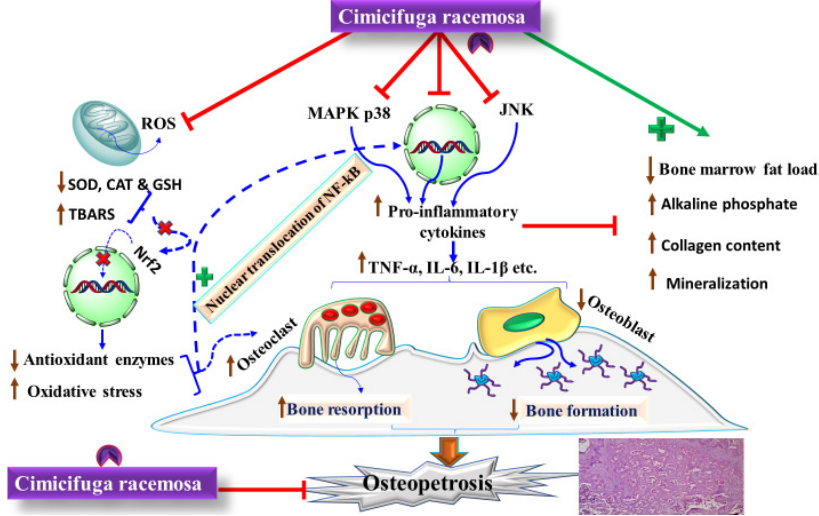
Figure 2. Showing the proposed mechanism of action of CR in post-menopausal-induced osteopo- Figure rosis.